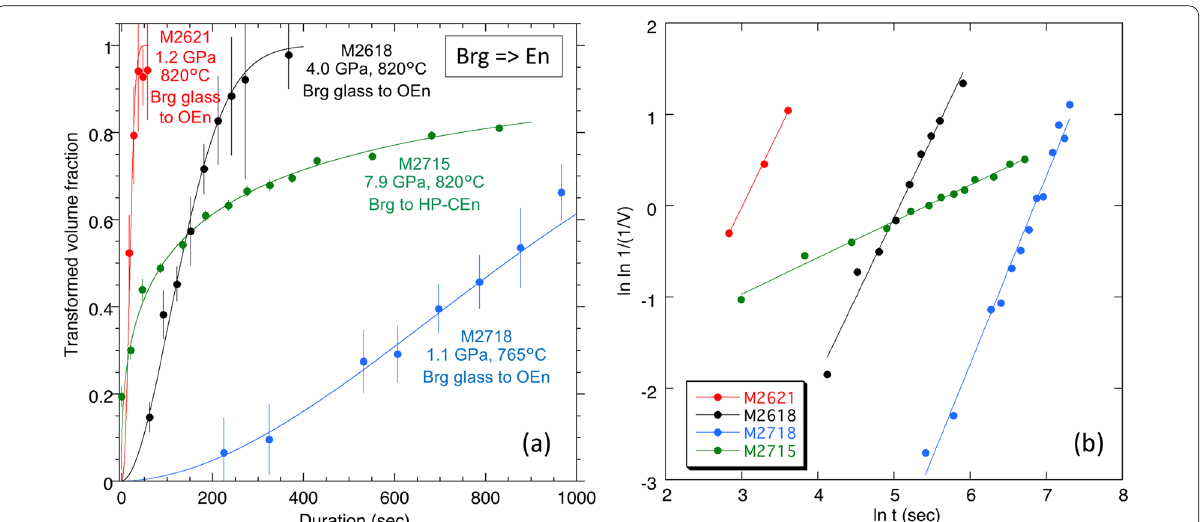
Fig. 11 Back-transformation kinetics in bridgmanite. a Transformation-time data for orthoenstatite crystallization from amorphous bridgmanite (red, black, and blue circles), and for direct back-transformation from bridgmanite to high-P clinoenstatite (green circles). b Plots of ln ln {1/(1 against ln ( t ). The n values (slope) are different depending on the reaction